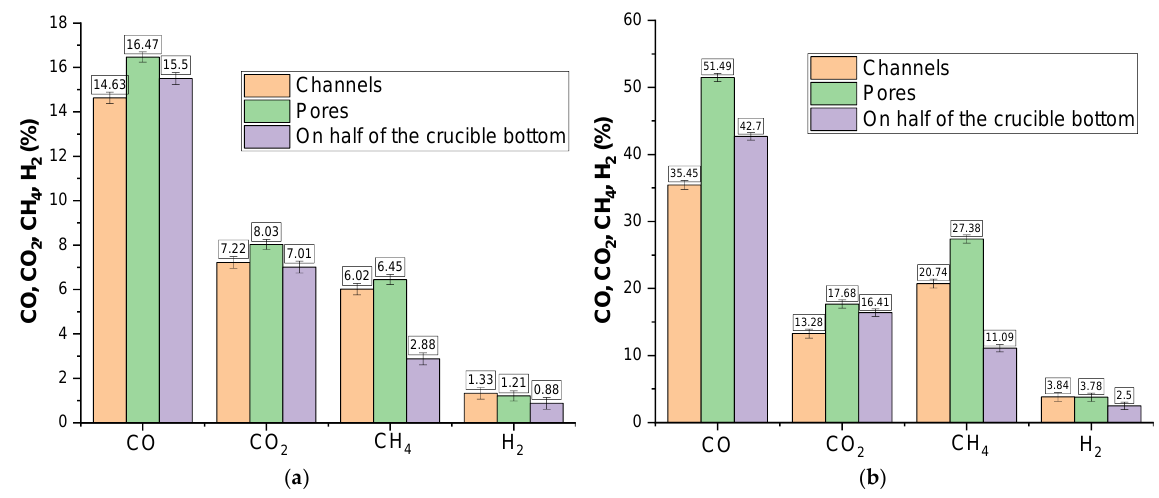
Figure 14. Average ( a ) and maximum ( b ) concentrations of the gas mixture components with varying surface structure of the biomass.